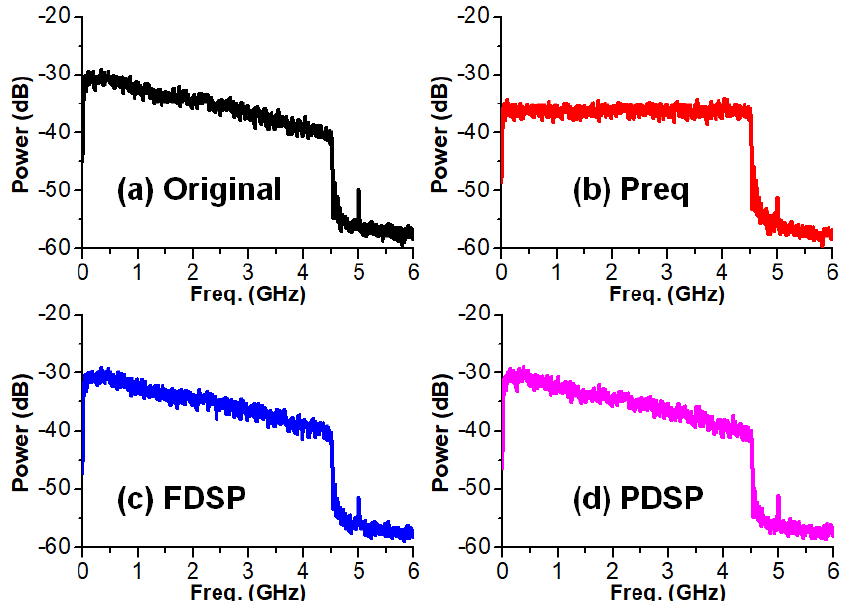
Figure 6. Spectra of the received signals with ( a ) original scheme, ( b ) Preq scheme, ( c ) WHT-based FDSP scheme and ( d ) Fast WHT-based PDSP scheme.